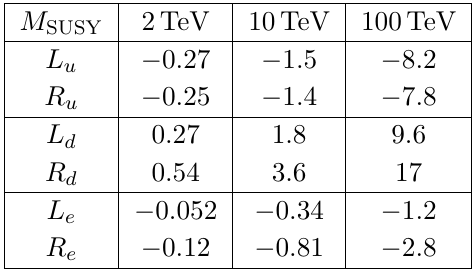
Table 3 . The results of s L;R